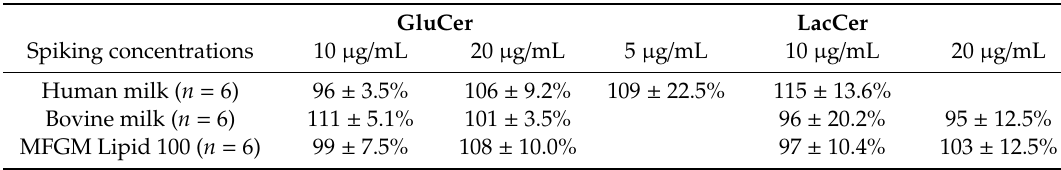
Table 3. Summary of spike recovery